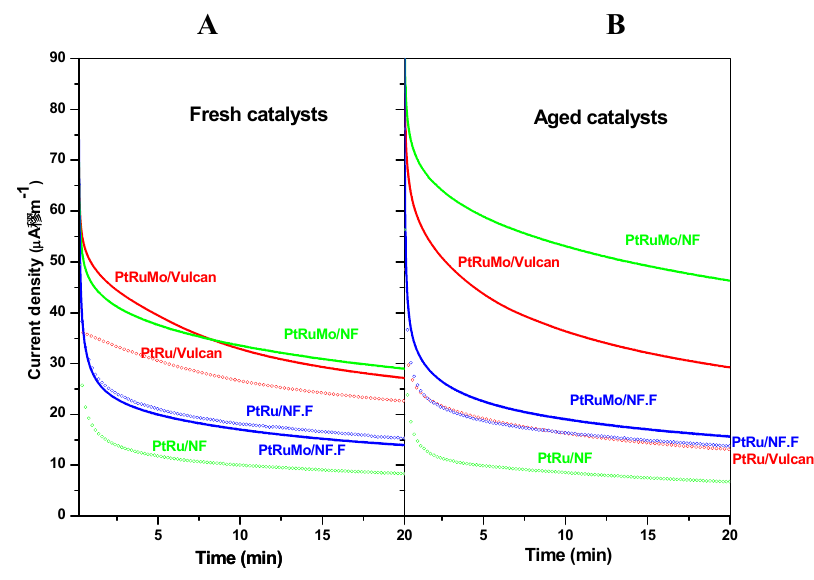
Figure 10. Current-time curves towards methanol oxidation at 0.45 V of fresh catalysts ( A ) and aged catalysts ( B ) in 2 M CH for the electroactive area estimated from CO time at 0.45 V. Adapted from Tsiouvaras et al.